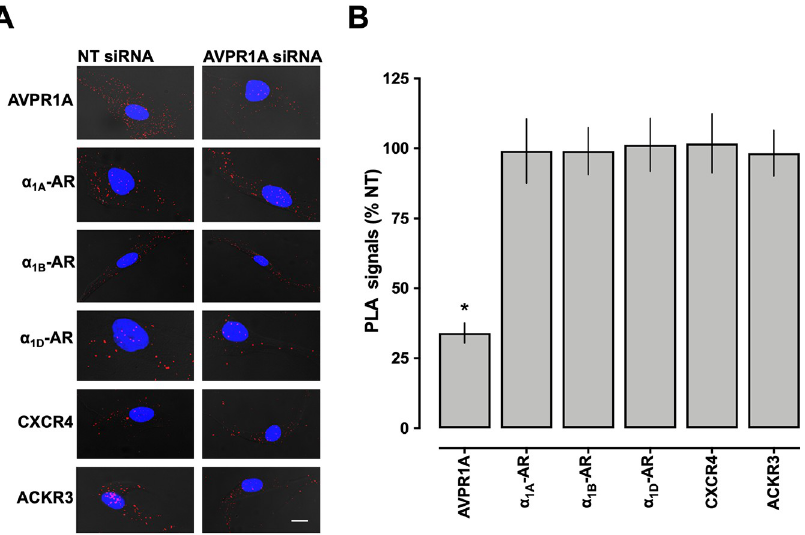
Fig 7. siRNA knockdown of AVPR1A in hVSMCs. ( A ) Representative PLA images for the detection of individual receptor protomers in hVSMC after incubation with non-targeting (NT) siRNA or AVPR1A siRNA. Images show merged PLA/4 0 ,6-diamidino-2-phenylindole dihydrochloride (DAPI) signals. Scale bar = 10 μ m. ( B ) Quantification of PLA signals for the detection of individual receptor protomers in hVSMCs after incubation with non-targeting (NT) siRNA or AVPR1A siRNA, as in A. PLA signals in cells incubated with AVPR1A siRNA are expressed as % of PLA signals in cells incubated with NT siRNA (= 100%). n = 4 independent experiments with n = 10 images per condition and experiment. � : p < 0.05 vs. cells incubated with NT siRNA.